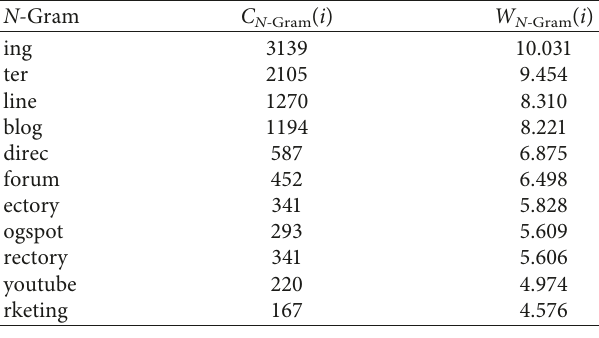
Table 2: The number of domain name substrings generated when N 3, 4, 5, 6, and 7. (cid:29)